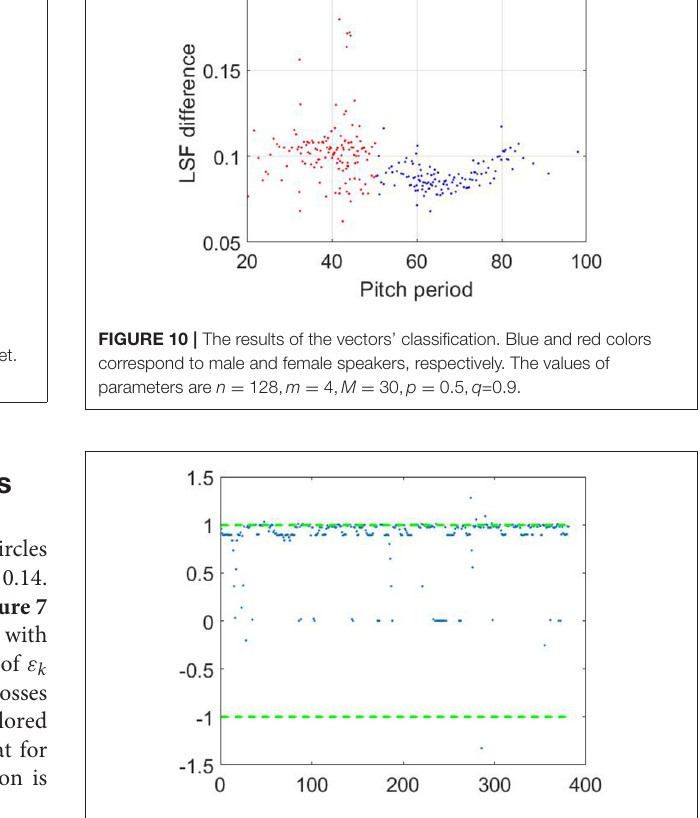
FIGURE 11 | The example of decisions for frames of an audio recording of a male speaker.